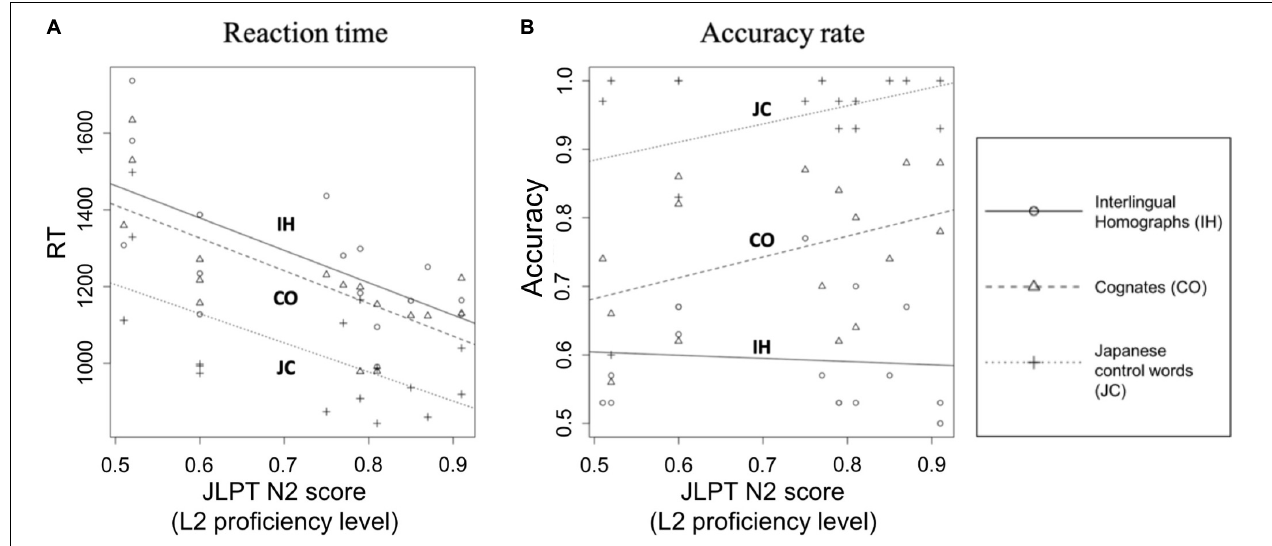
FIGURE 2 | Relationship of proficiency level with participants’ mean RT and mean accuracy rate. In (A) , the x -axis indicates the bilinguals’ proficiency level. The y -axis indicates the mean RT to each L2 word type (CO, cognate; JC, Japanese control word; IH, interlingual homograph). The proficiency level was consistently related to the response to Japanese words. Higher proficiency levels were associated with faster RTs. In (B) , the y -axis indicates the bilinguals’ mean accuracy rate for each L2 word type. The RT tendency in (A) was not observed in the accuracy rate data. Higher proficiency levels were associated with a relatively low accuracy rate for IHs in comparison with COs and